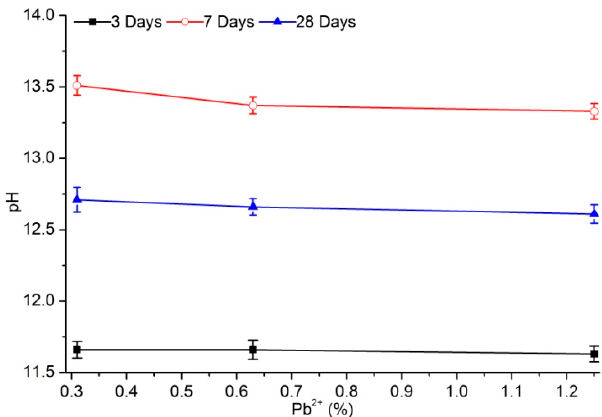
Figure 4. pH of percolate from samples stabilized with PS.